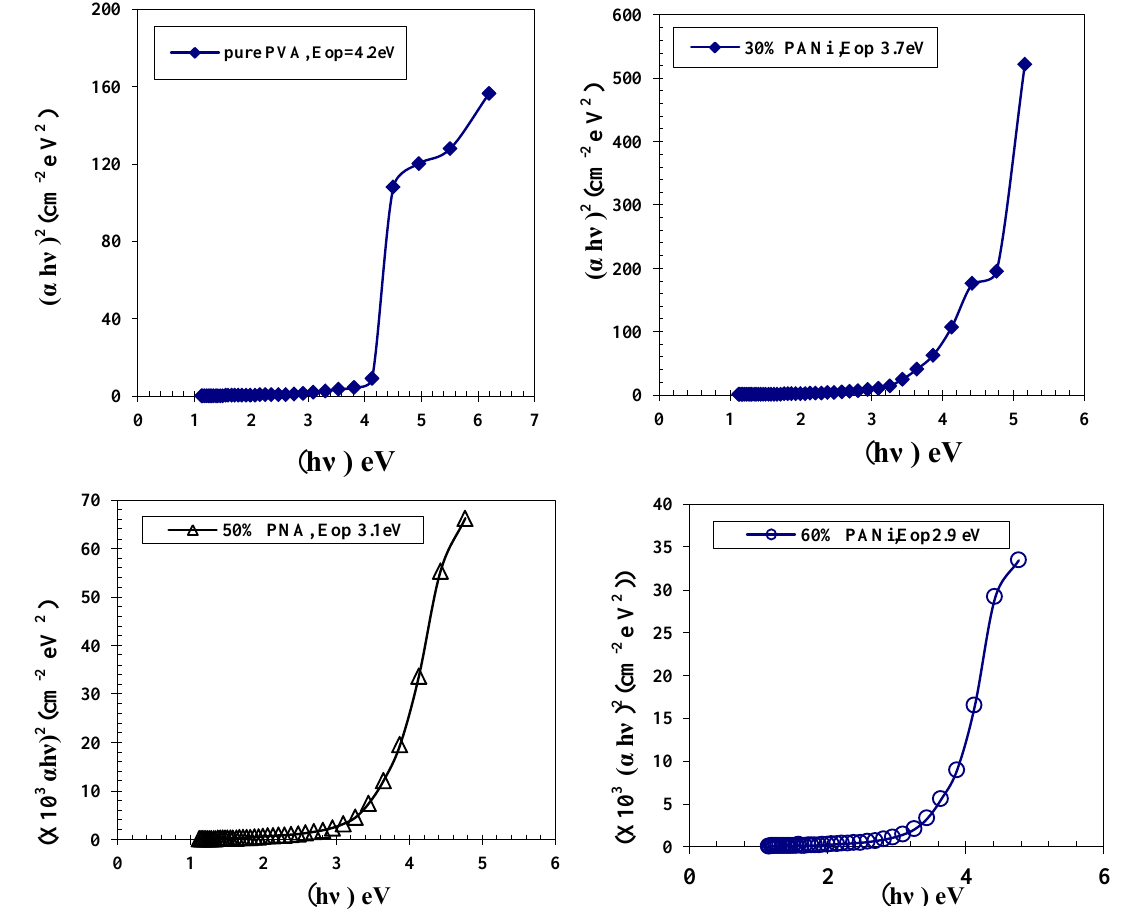
Fig. 4: (αhv) 2 vs. (hv) for (PVA +PNAI) blends polymer prepared with different PNAI